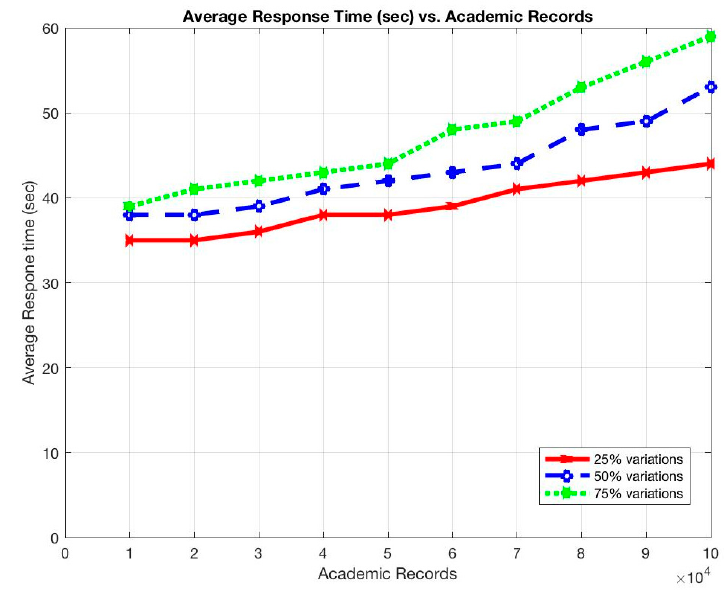
Figure 9. Average response time (s) vs. academic records.